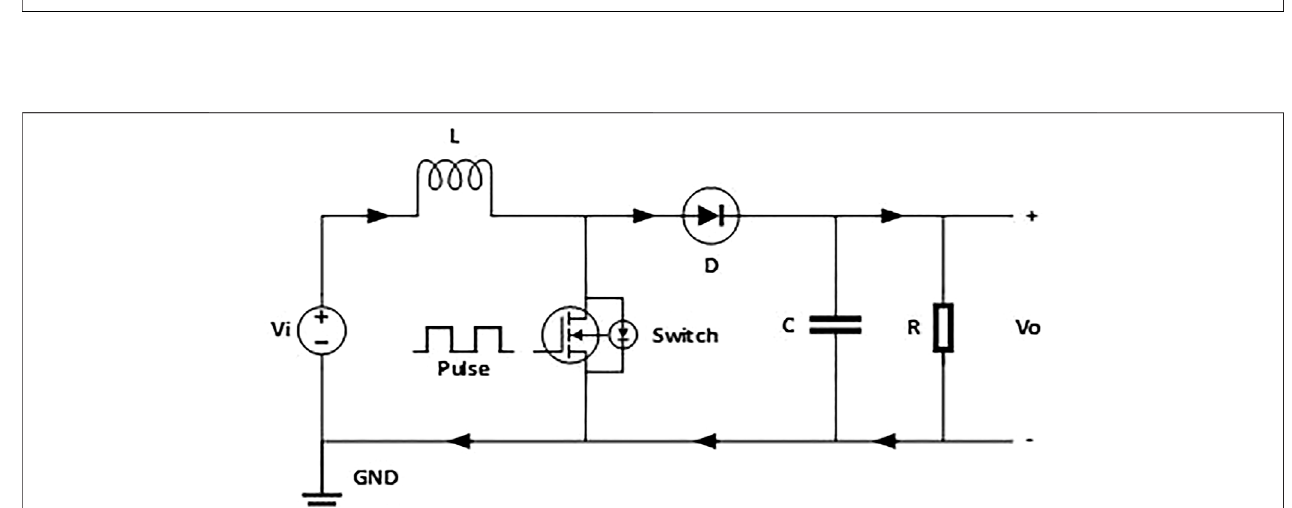
FIGURE 1 | Structure of PV energy system.